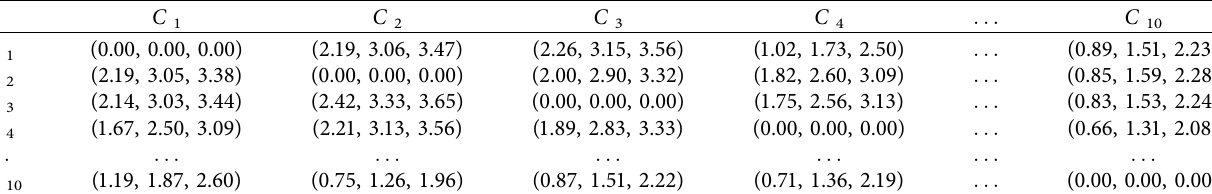
Table 4: Direct relation matrix of the group ( Z -numbers).